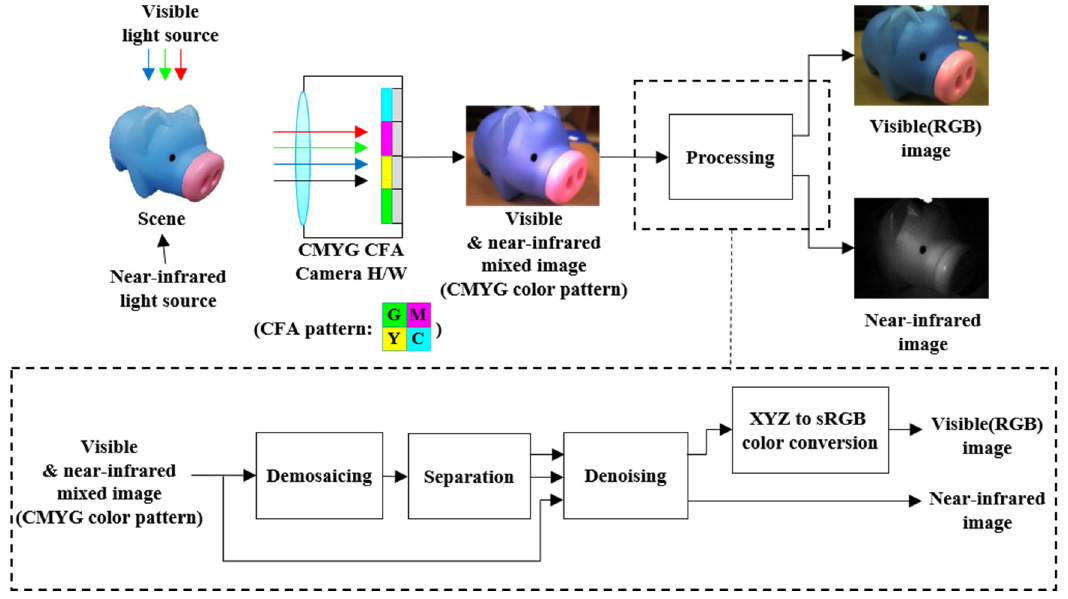
Figure 1. The proposed visible and near-infrared imaging system structure.